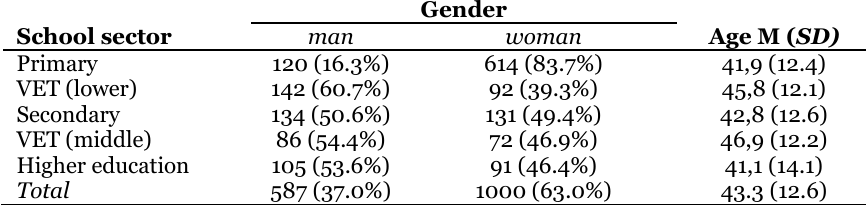
Teachers Distributed Over School Sector, Gender, and Age (N=